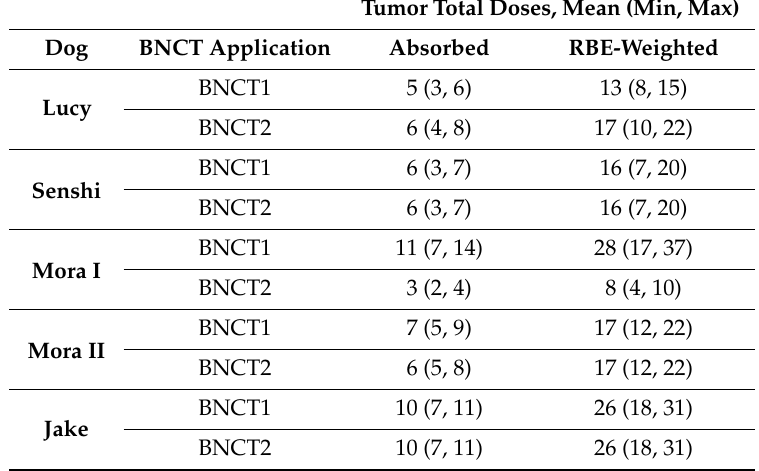
Table 1. Tumor doses for the 5 veterinary patients treated with the B2 clinical beam of the RA-6 reactor. BNCT1 and BNCT2 correspond to the first and second BNCT application (3–5 weeks apart), respectively. Tumor Total Doses, Mean (Min, Max)